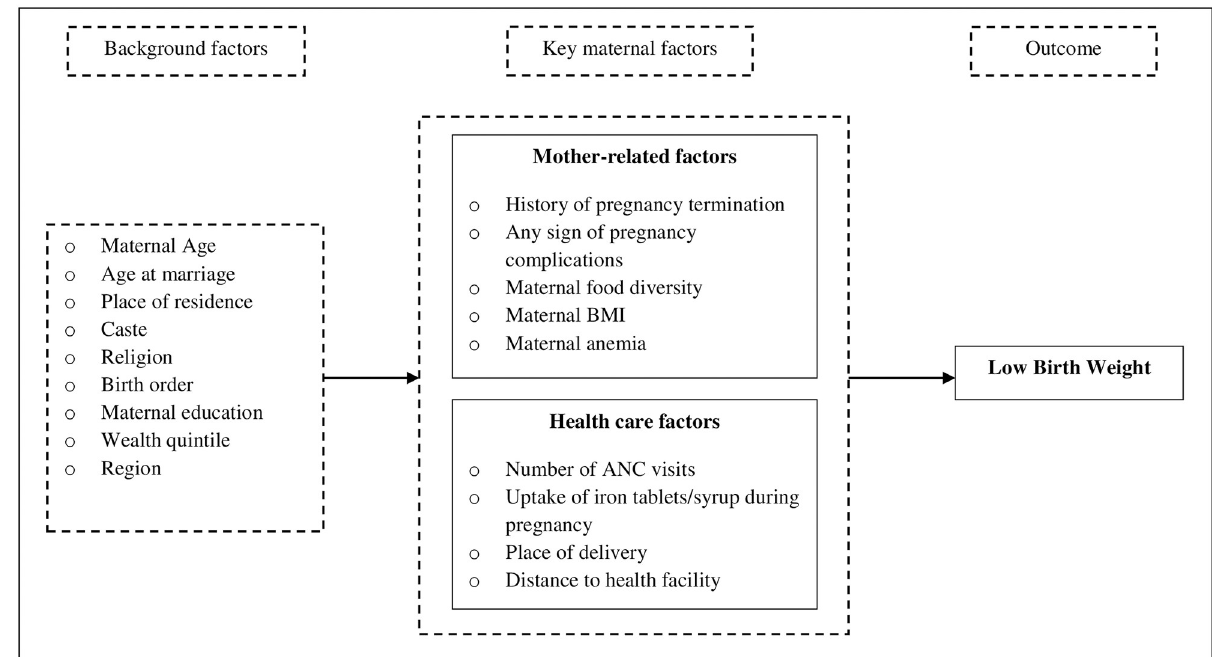
Fig 1. Conceptual framework showing maternal determinants of low birth weight.